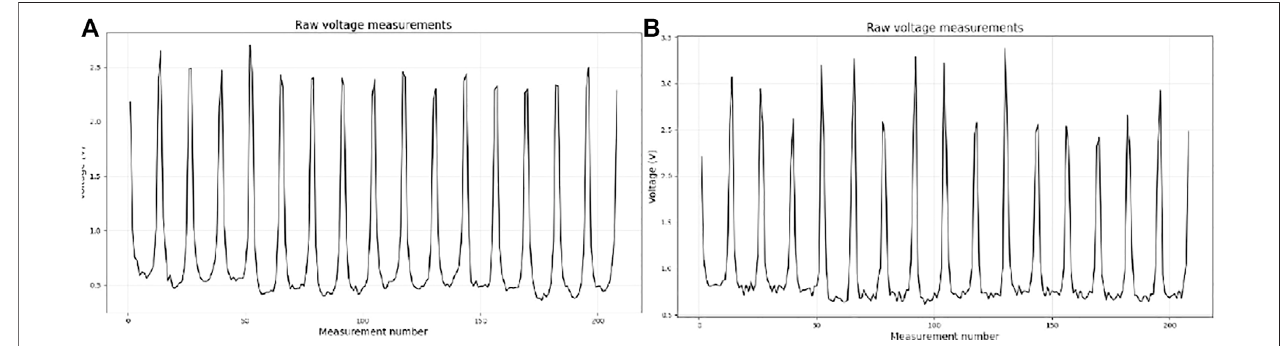
FIGURE 7 | Saline- fi lled phantom raw voltages, showing typical “ U ” shapes. (A) Data acquired by hand selection of electrodes. (B) Data acquired via multiplexers.